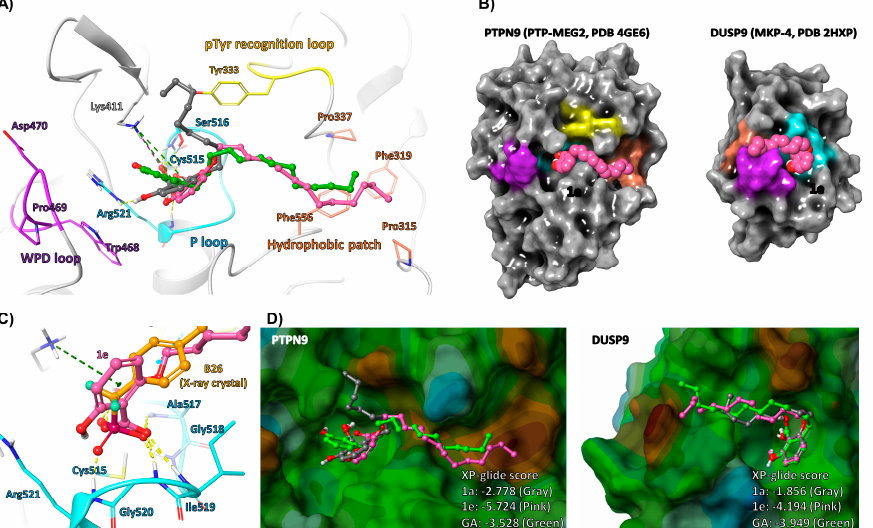
Figure 3. Docking model between GA and its analogs and PTPN9 and DUSP9. ( A ) Binding pose of GA and its analogs on PTPN9. Here, 1a (gray), 1e (pink), and GA (green) are presented in a ball-and-stick model. PTPN9 is represented as a series of white ribbons, and the key structure and residues are highlighted. Hydrogen bonds, cation– π interactions, and the salt bridge are represented with yellow, green, and purple dashed lines, respectively. ( B ) Surface representation of PTPN9 and DUSP9. The docking pose for 1e is represented in CPK. The location of the key structure is highlighted with the corresponding color. ( C ) Superimposition of the docking model of 1e and X-ray ligand (B24, orange) on P-loop. ( D ) Lipophilic surfaces of PTPN9 and DUSP9 with GA and GA analogs. Blue and brown indicate where hydrophilic and lipophilic features are dominant,